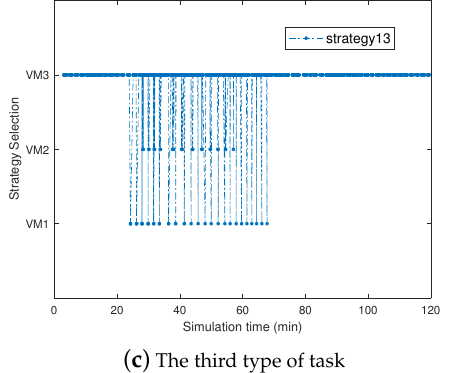
Figure 9. Dynamic VM Assignment for Different Types of Task in the Same Region.